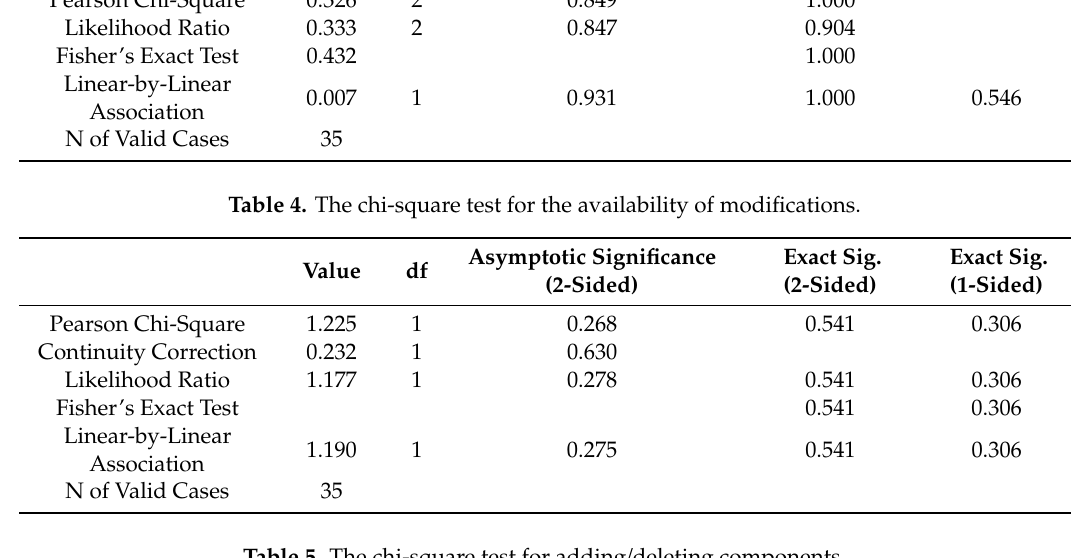
Table 5. The chi-square test for adding / deleting components.